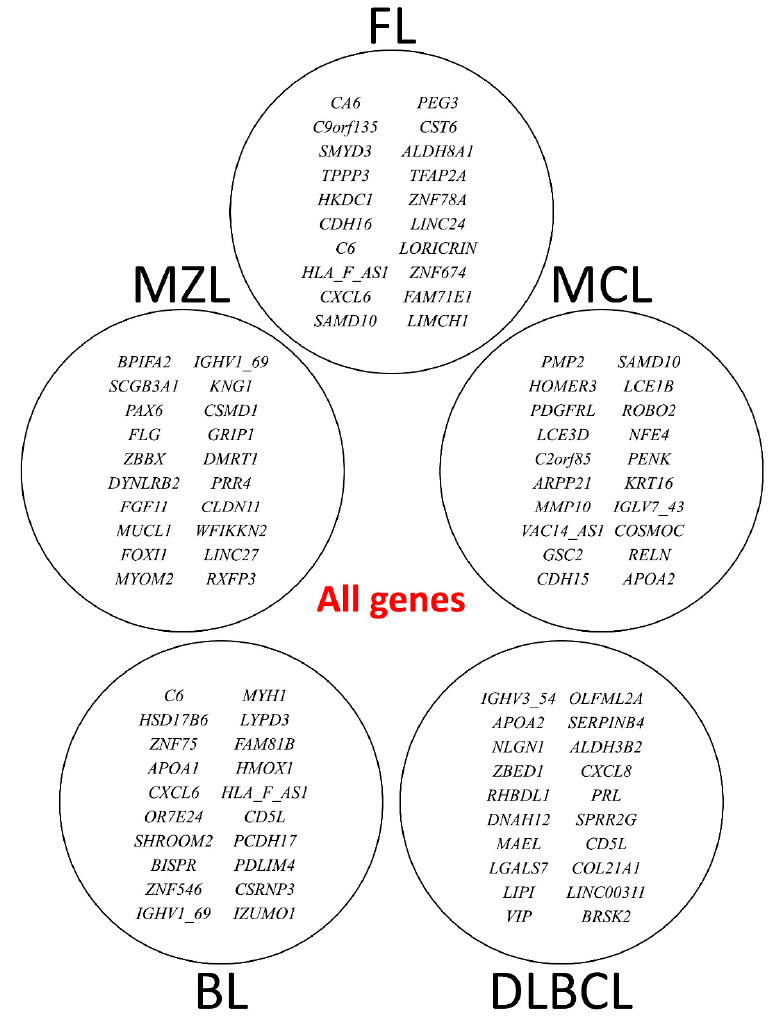
Figure 5. Prediction of each NHL subtype by all genes of the array ( n = 20,863) using MLP analysis. This figure shows the top 20 genes of the MLP analysis according to their normalized importance for predicting an NHL subtype against the other subtypes. For example, CA6 was the most important gene for predicting FL vs. the other NHL subtypes (i.e., FL vs. MCL + DLBCL + BL + MZL). Table 4. Prediction of each NHL subtype by all genes of the array ( n = 20,863) using MLP analysis. MLP FL vs. Others MCL vs. Others DLBCL vs. Others BL vs. Others MZL vs.